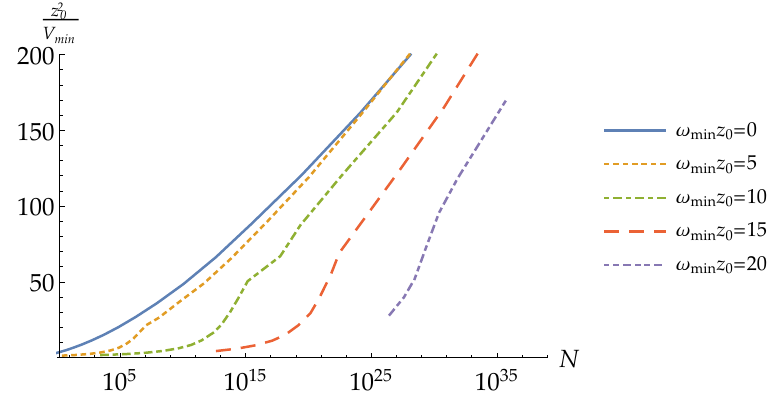
Figure 3 . Plot of z 2 ( V min ) (cid:0) 1 vs N on a semi-log scale, where V min is the minimum variance of an 0 initial data function and N is the ratio of the L 2 norm of sources to the L 2 norm of the initial data function. This (cid:12)gure uses ! max z 0 = 40 and (cid:15)z 0 = 1 and plots the results for values of ! min z 0 listed 5 in the legend. The curve suggests that the minimum variance approaches zero as the norm of the sources is increased for any choice of ! min z 0 .